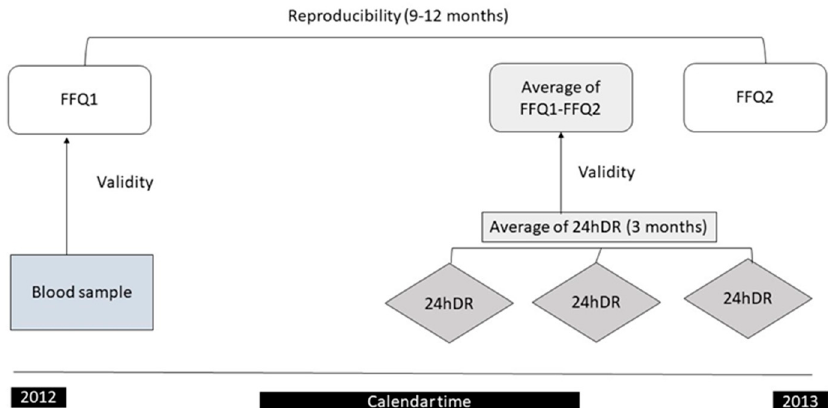
Figure 1. The desing of the validation study among children aged 7 to 9 years of the INMA (Infancia y Medio Ambiente (Environment and Childhood)) project in Valencia, 2012–2013. FFQ: food frequency questionnaire; 24hDR: 24-hour dietary recall.